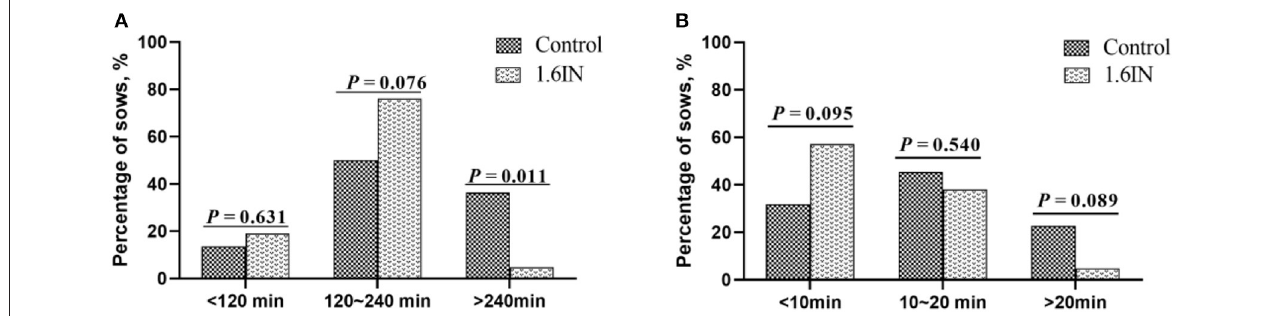
FIGURE 2 | Distribution of (A) farrowing duration and (B) average piglet birth interval of sows. N = 20 for the control group and 1.6IN group. Significance was analyzed by chi-squared test.